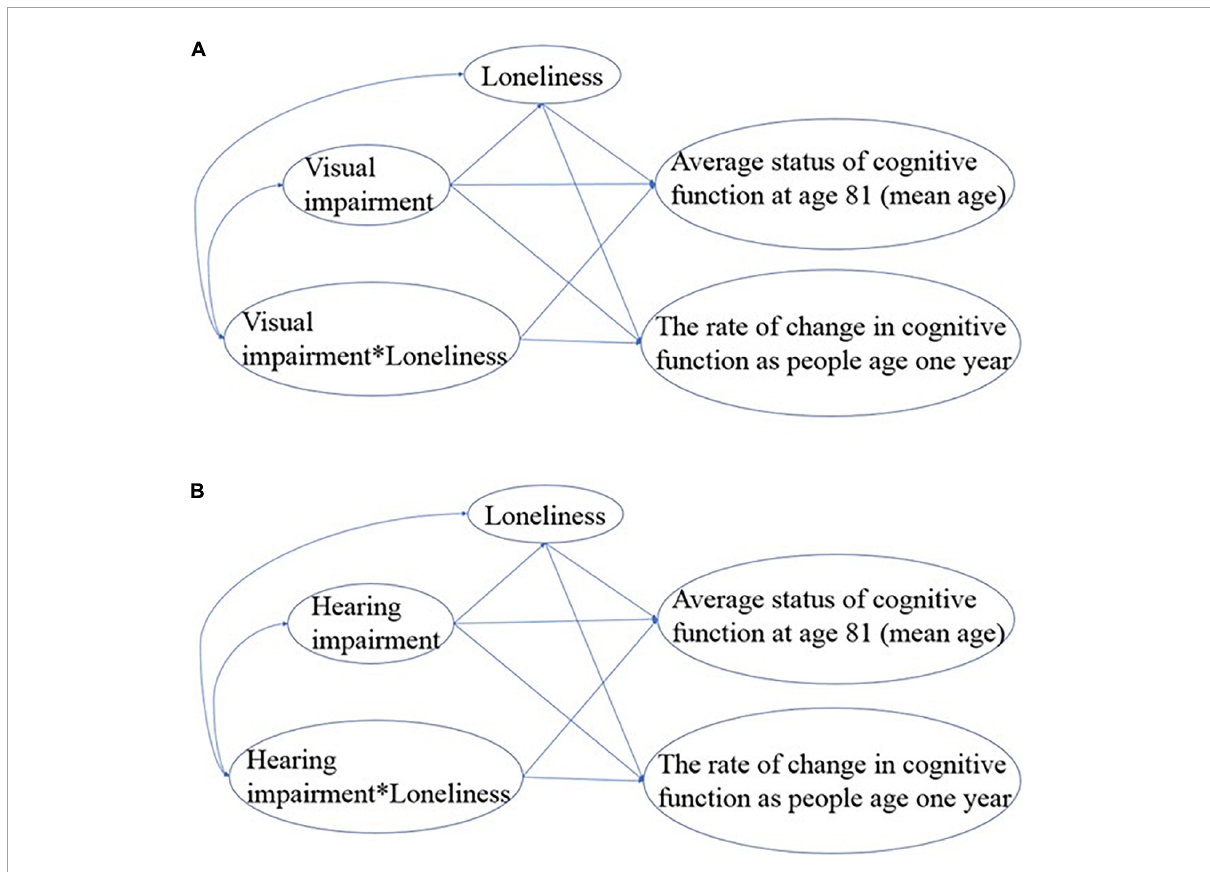
FIGURE2 Initial mediation and moderation SEM models for (A) vision and (B) hearing impairment.